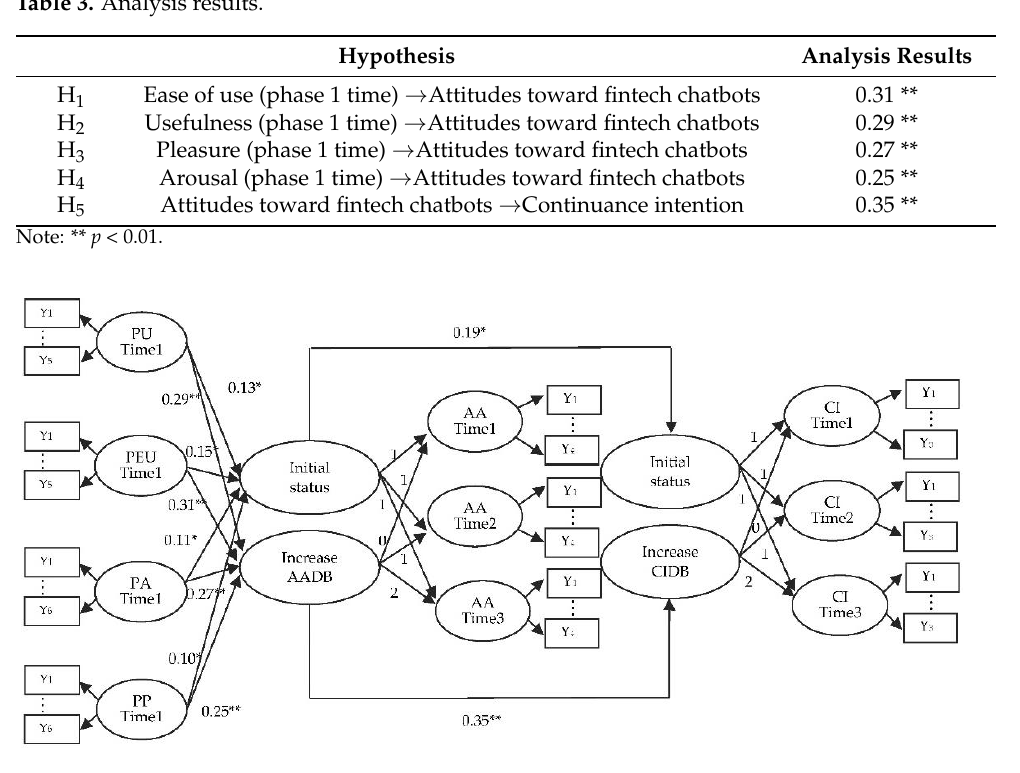
Table 3. Analysis results.